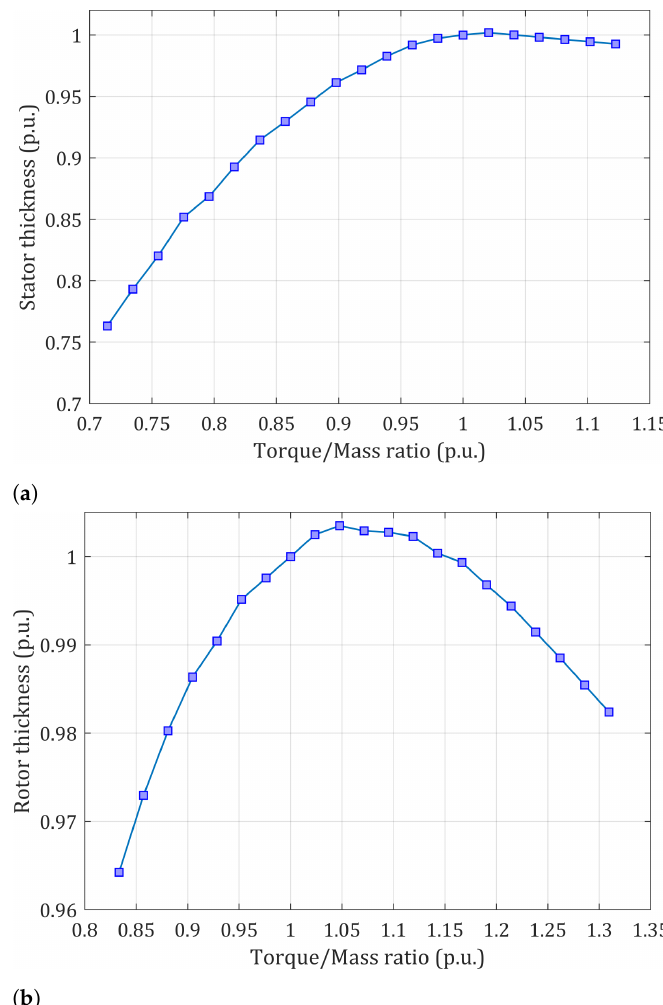
Figure 10. Impact of yoke thicknesses on the torque-density ( a ) stator and ( b )